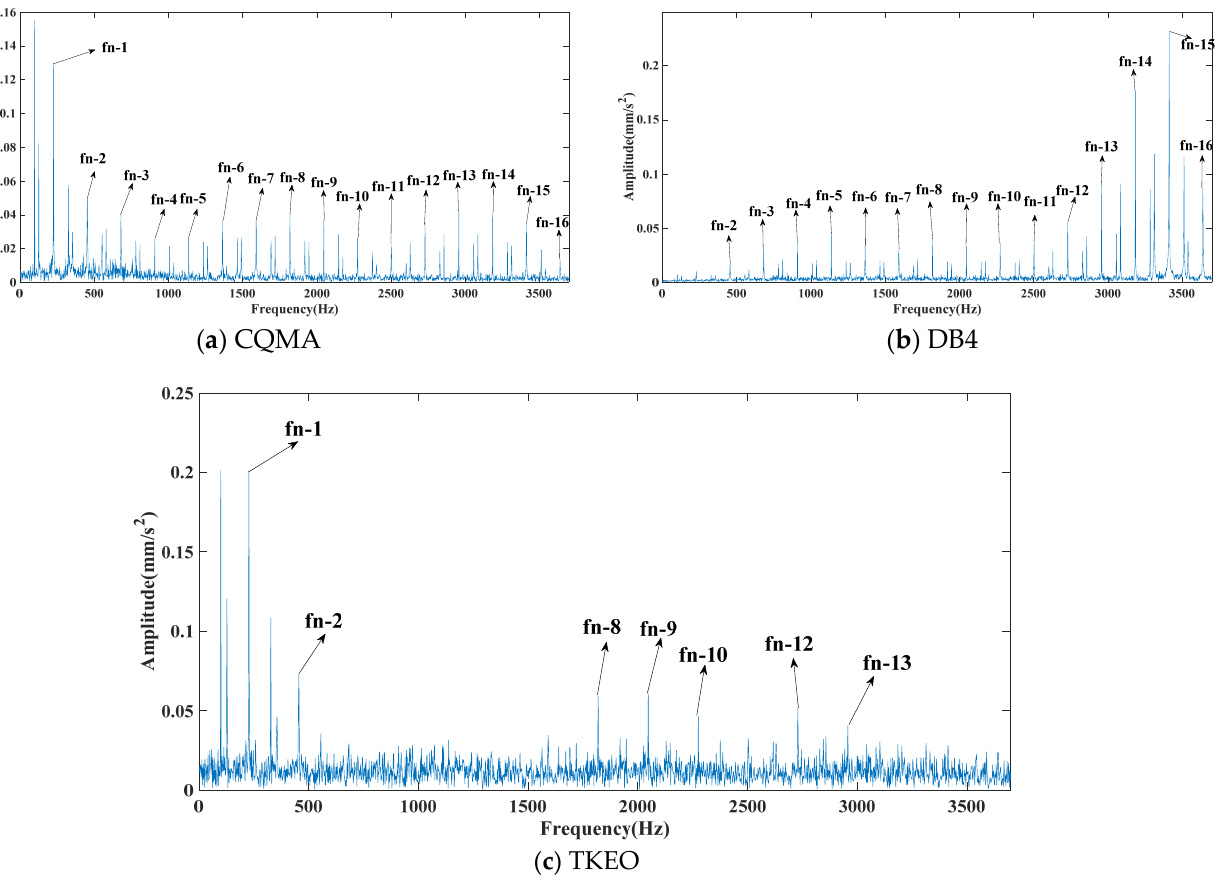
Figure 6. Comparison chart of the envelope spectrum results of the composite quantum morphology analysis (CQMA), DB4, and Teager–Kaiser energy operator (TKEO) methods: ( a ) CQMA, ( b ) DB4 wavelet, and ( c ) TKEO.